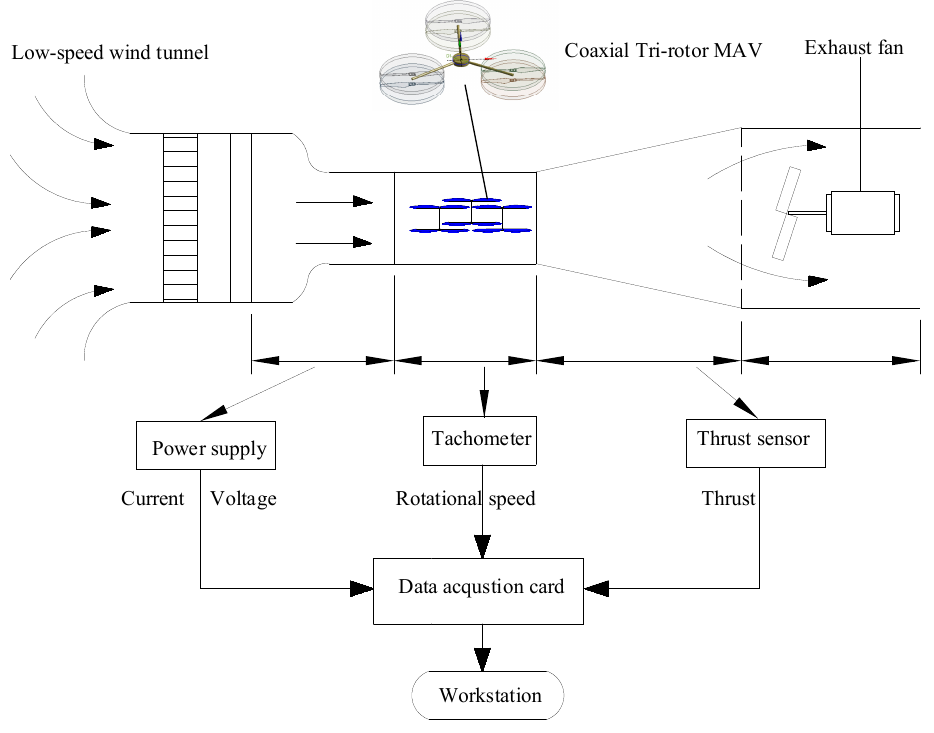
Figure 4. Experimental process.